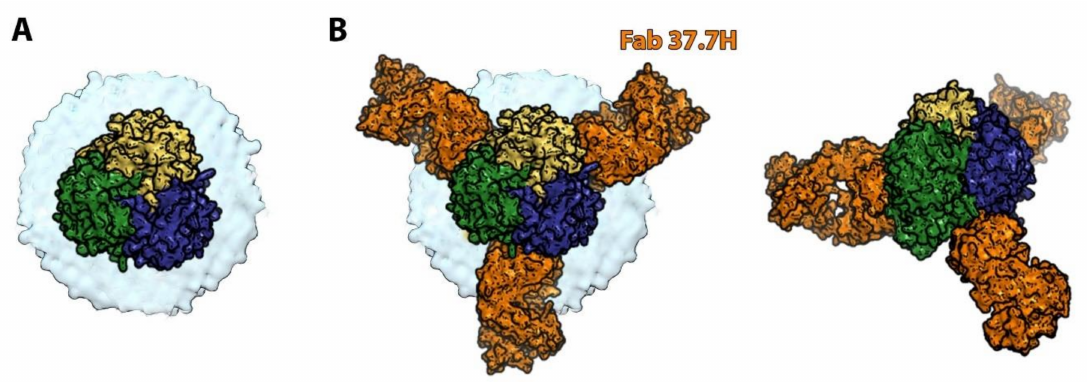
Figure 4. The Lassa virus glycoprotein spike alone and in complex with a neutralizing mAb. ( A ) Representation of Lassa virus glycoprotein trimer. Each monomer is composed of GP1 and GP2 and is displayed in a different color (green, yellow and blue). The membrane is drawn in light blue. ( B ) Modelling of the interaction of Lassa virus spike with a neutralizing antibody displayed in orange. mAb 37.7 binds two GP monomers near the base of the GP